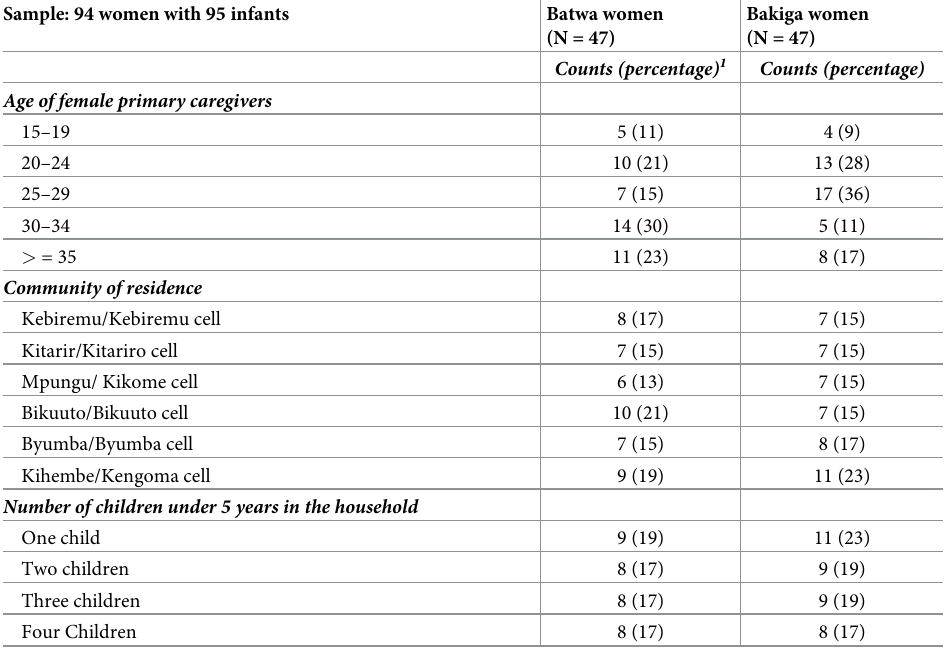
Table 1. Description of the women and children participating in the study. Sample: 94 women with 95